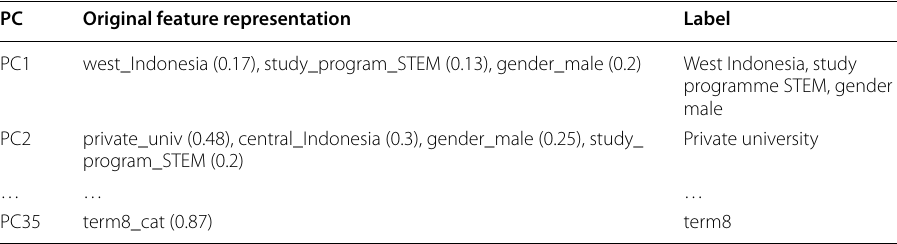
Table 3 Feature representations for each principal component (truncated)